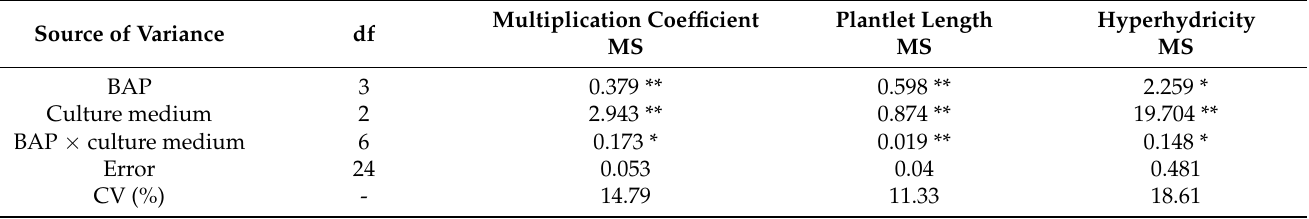
Table 1. Analysis of variance of the effects of the different concentrations of BAP and the basal culture medium type on the measured characteristics of the Pyracantha angustifolia plants grown in vitro in the multiplication